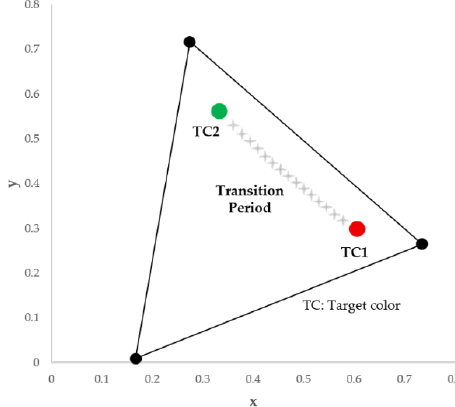
Figure 8. The transition example of a target color of a traffic sign from green to red under GCM based communication between LED and PD.